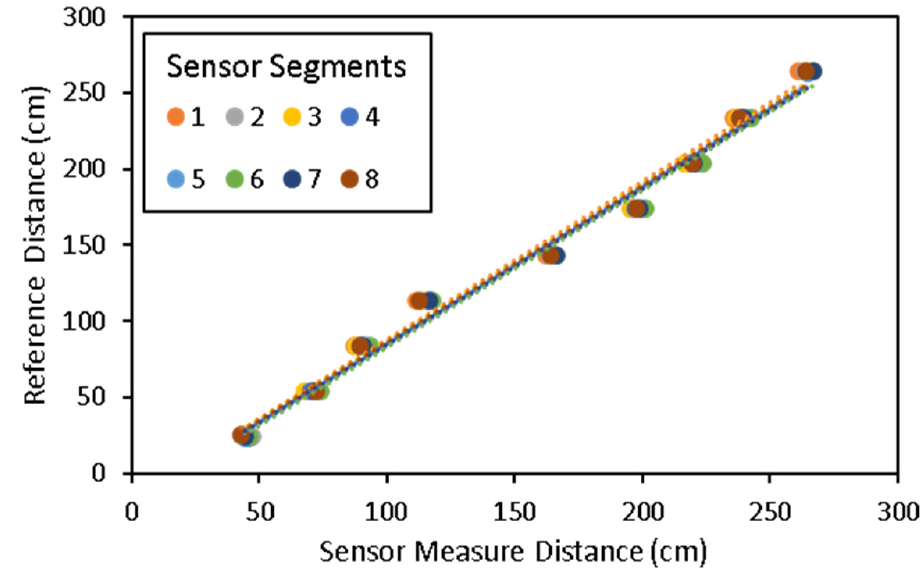
Figure 8. Correlation model between the sensor measured distance and the reference distance. The figure contains the measurement for each of the eight detector elements. Fitted regression models were generated individually for all the detector elements.